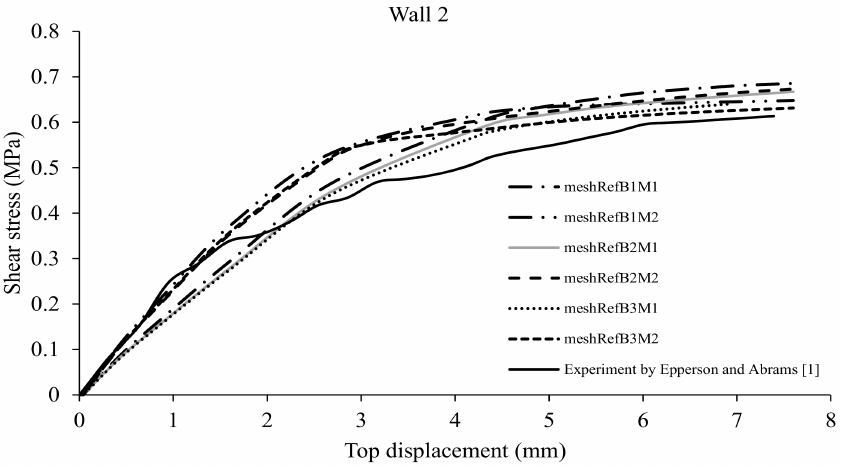
Figure 6. Mesh convergence results for the model “Wall